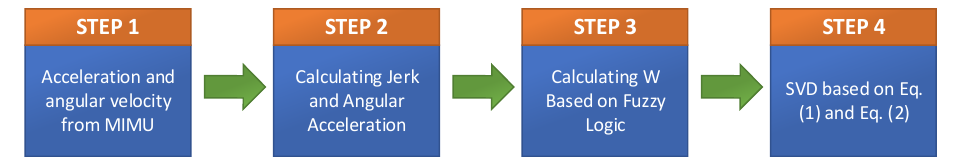
Figure 6. Basic implementation steps of the ZVD based on the adaptive detection interval.